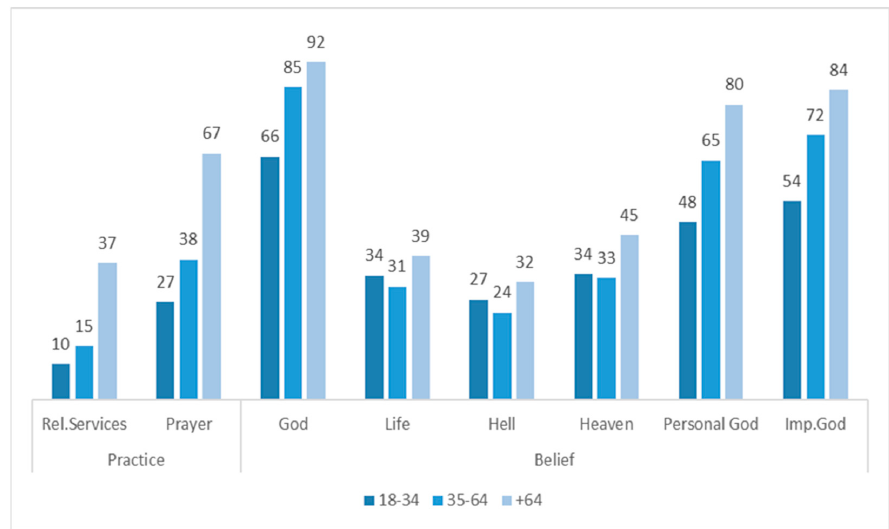
Figure 2. Practice and belief variables by age group in Portugal in 2020 (%). Source: EVS (2021) .